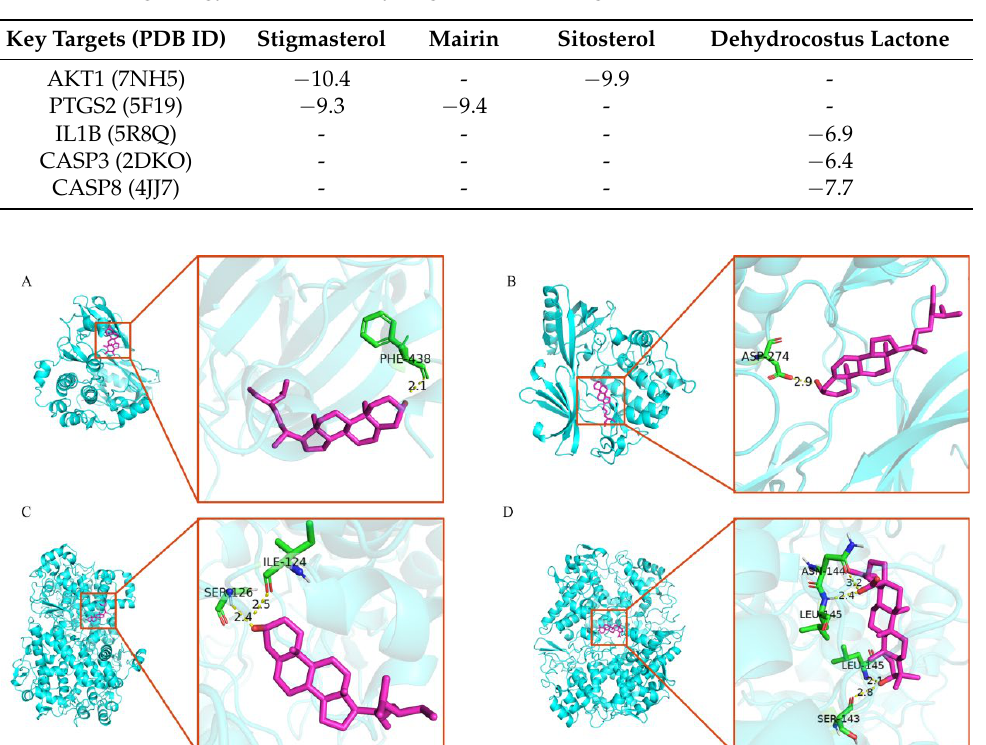
Figure 8. Results of gastric morphology. ( A ) Control group. ( B ) Model group. ( C ) Ranitidine group. ( D ) ARE 0.15 g/kg group. ( E ) ARE 0.3 g/kg group. ( F ) ARE 0.6 g/kg group. ARE, Aucklandia Radix ethanol extract. The quantitative analysis of the ulcer area was consistent with the morphological ob- servations (Table 5). Compared with the model group, the ulcer areas in the ranitidine and ARE 0.6 g/kg groups were reduced obviously ( p < 0.05). Among the three dose groups of ARE, the ARE 0.6 g/kg group had the lowest ulcer area along with the highest inhibition rate (50.26%, p < 0.05).